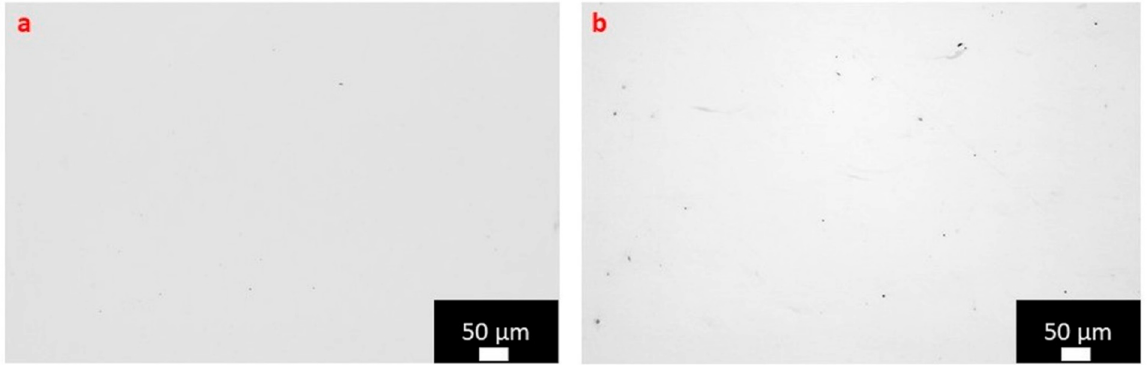
Figure 2. LOM images of the polished IN625 ( a ) and IN625mod ( b ). The microstructure of the etched samples of IN625 and IN625mod are displayed in Figure 3. These micrographs underline the microstructure of AB IN625 state (Figure 3a,b) and the microstructure of the AB IN625mod state with residual segregations indicated by red arrows (Figure 3c,d). These Ti-rich segregations tend to be located along the melt pool contours, as clearly displayed in the EDS maps reported in Figure 3e.